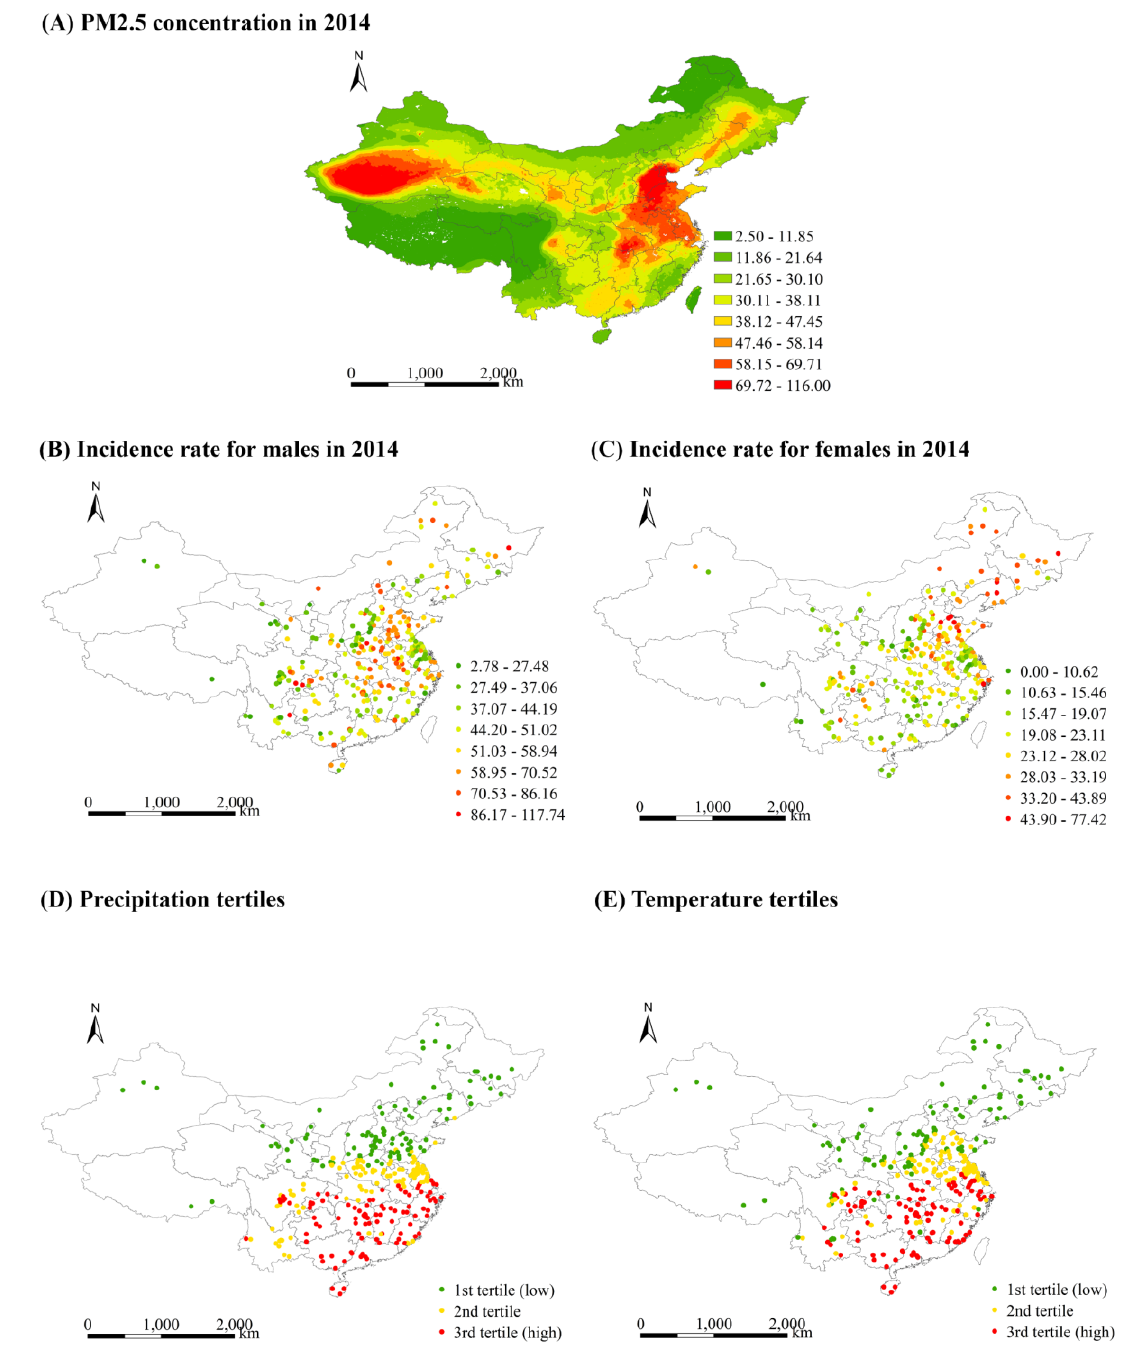
Figure 2. Spatial distribution of PM2.5, lung cancer outcome, and modifiers of temperature and